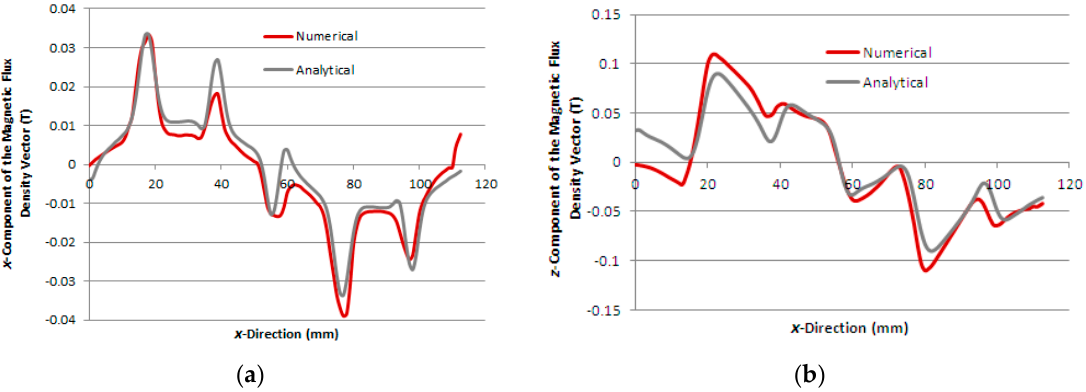
Figure 6. Components of the magnetic flux density vector as a function of x -direction, case 1: ( a ) x -component and ( b ) z -component. Sensors 2016 , 16 , 407